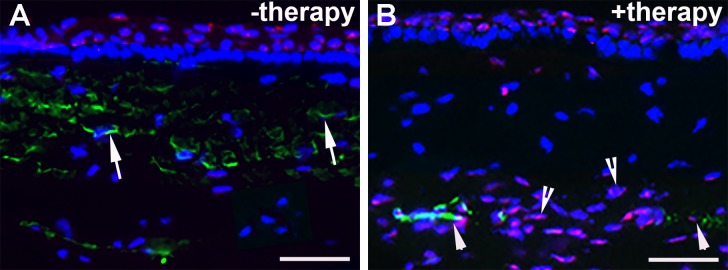
Double immunofluorescence staining for α-SMA and TUNEL in tissue from injured corneas treated with (A) PEI2-GNP alone (−therapy) and (B) PEI2-GN–delivered BMP7+HGF (+therapy). Arrows point to α-SMA; arrowheads point to colocalization of α-SMA-positive and TUNEL-positive cells; and arrowheads with inside tail point to TUNEL-positive cells. Scale bar: 25 μm.